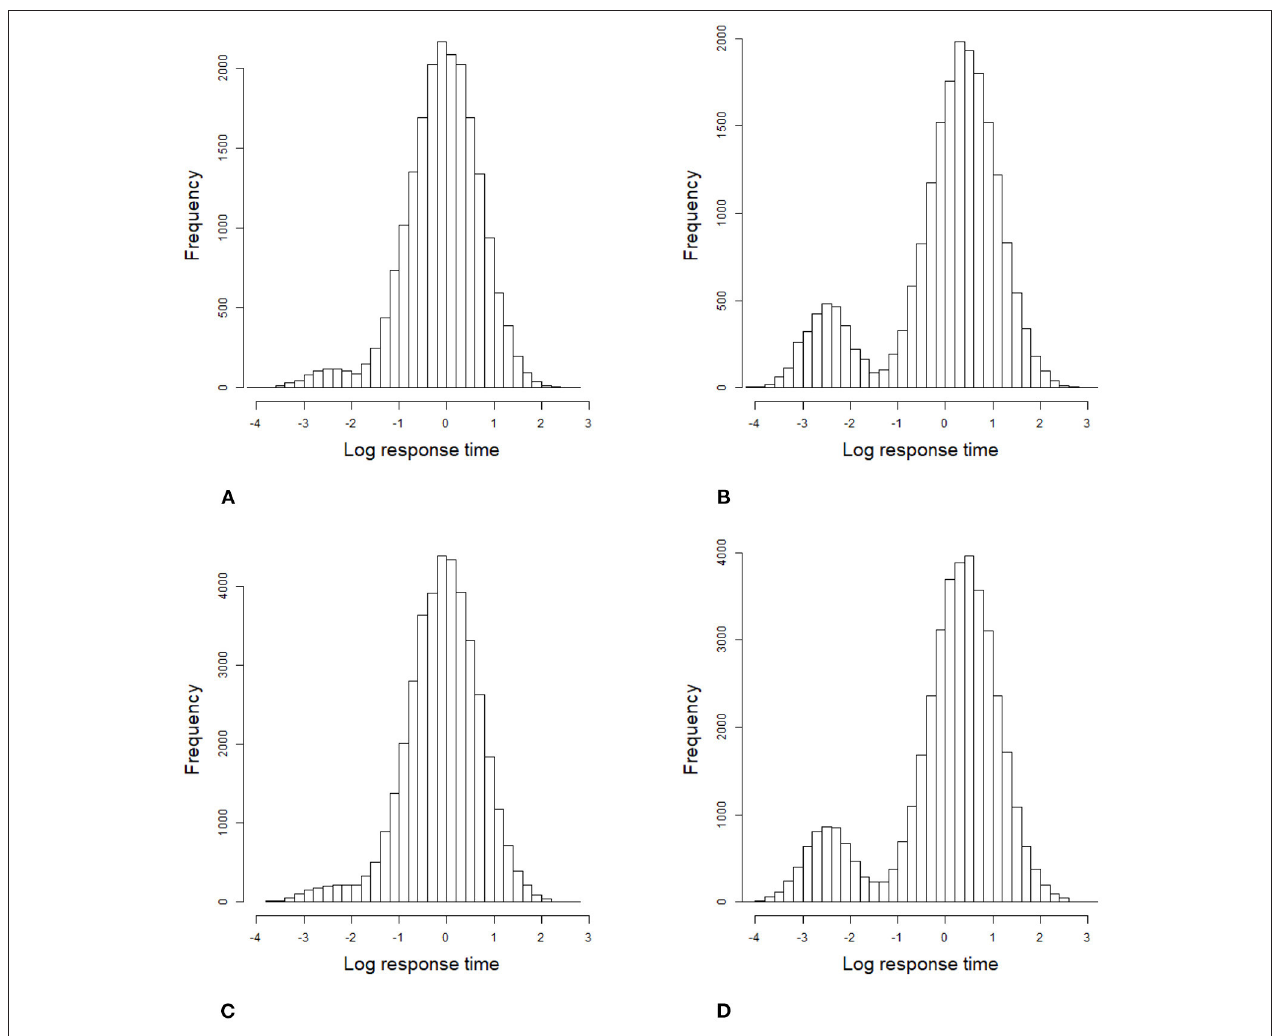
FIGURE 3 | Histogram of 1,000 examinees’ response times based on all item–person combinations in the simulation study 1. (A) items 20 and low speededness, (B) items 20 and high speededness, (C) items 40 and low speededness, and (D) items 40 and high speededness.